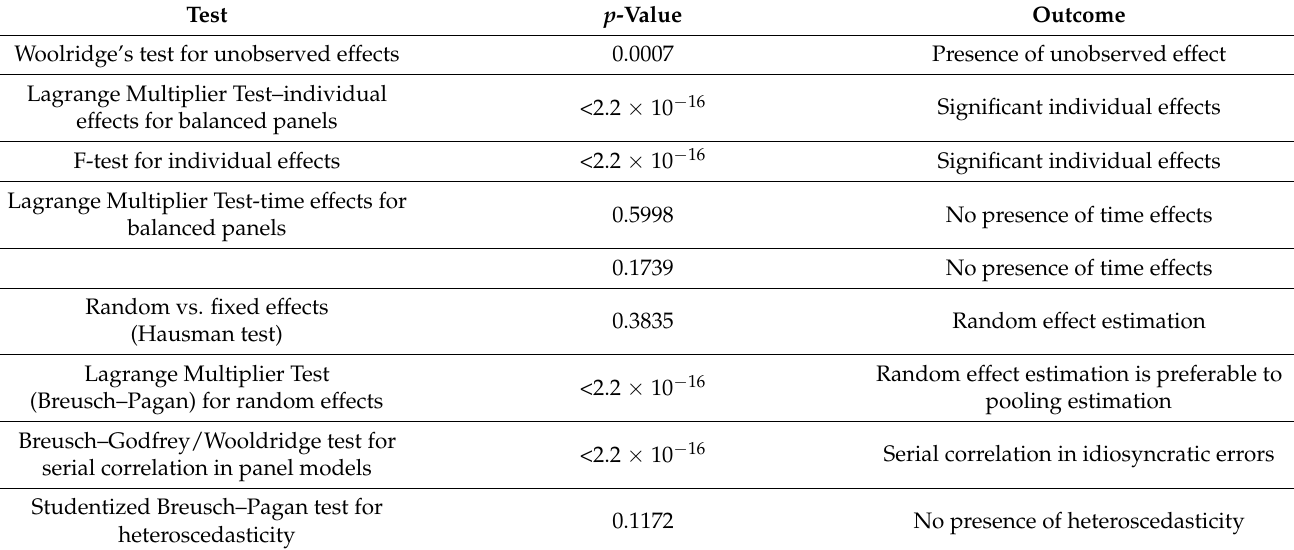
Table 2. Output from statistical